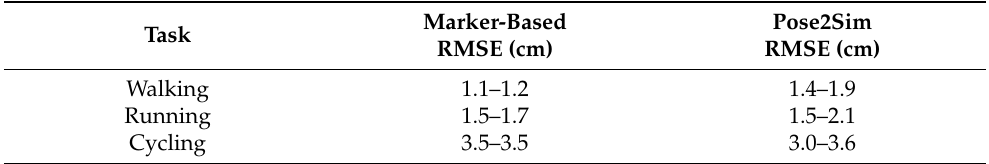
Marker-Based RMSE (cm)